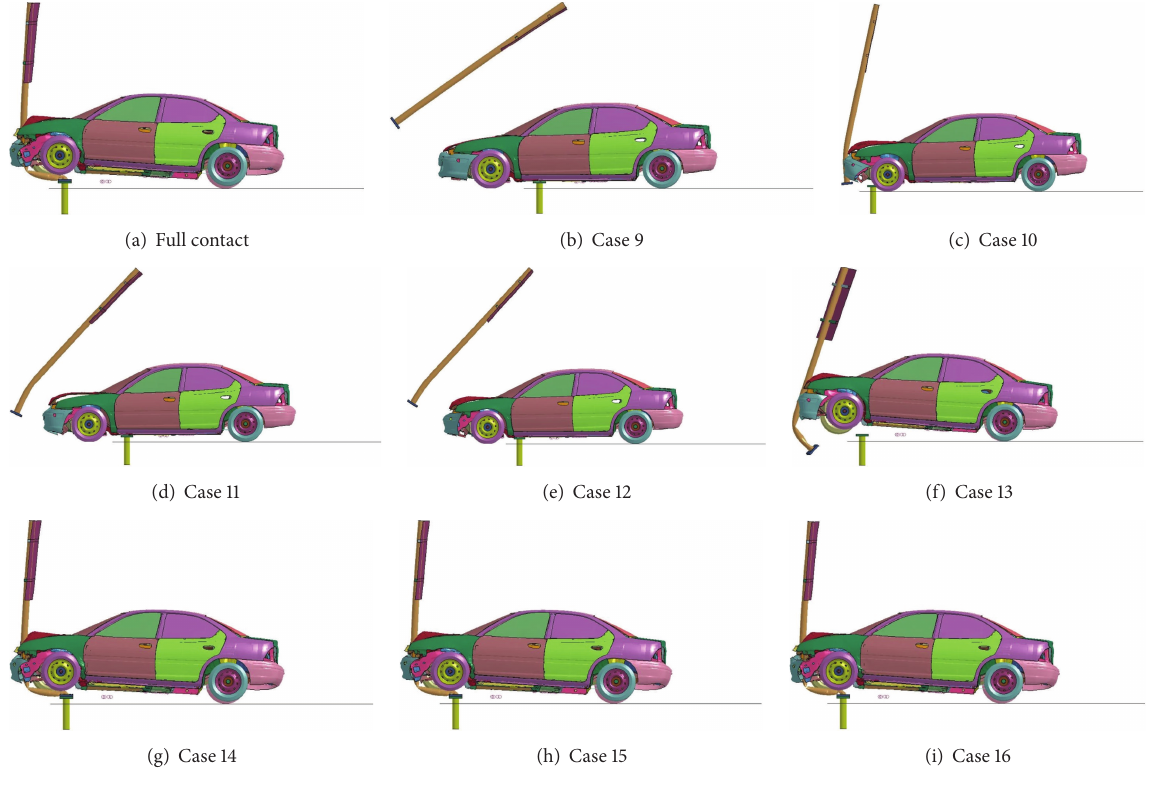
Figure 15: Deformed shapes for different cases (SM490).